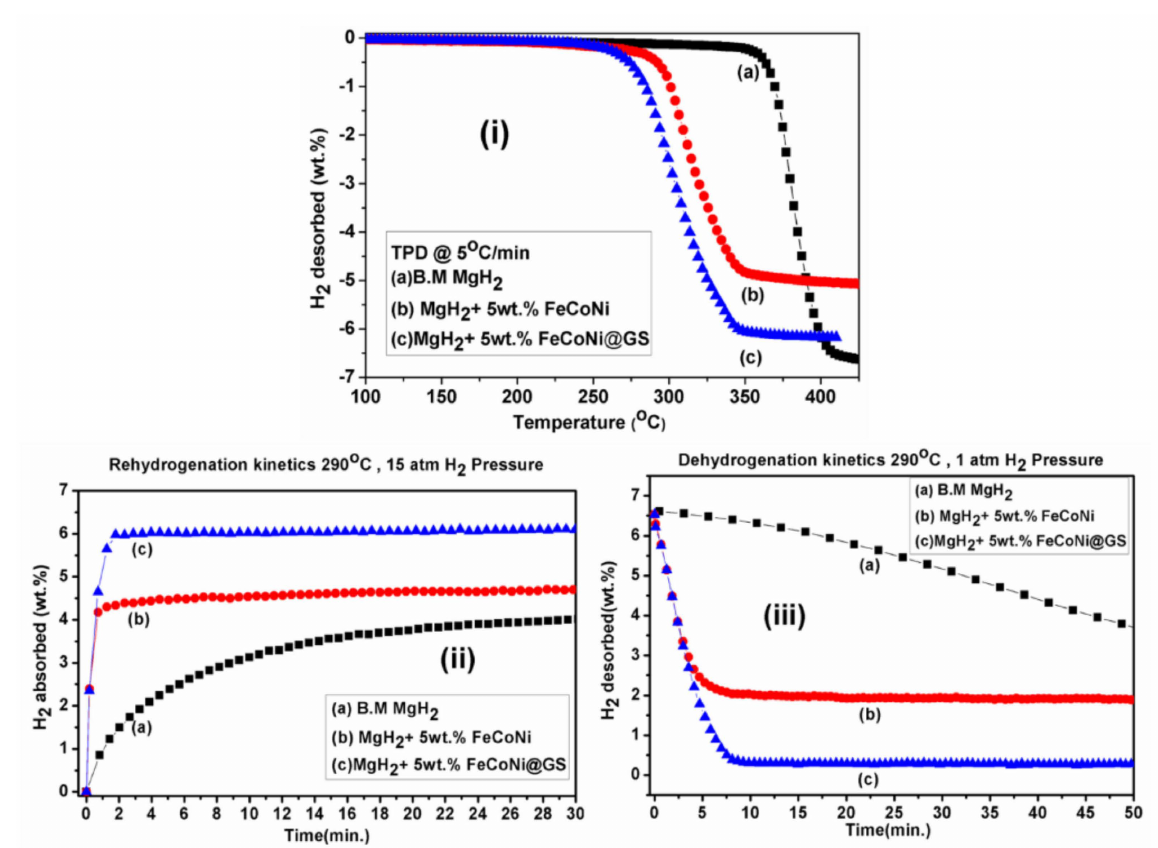
Figure 19. ( i ) TPD profile of (a) B.M MgH 2 (uncatalyzed sample); (b) MgH 2 + 5 wt% FeCoNi; (c) MgH 2 + 5 wt% FeCoNi@GS. ( ii ) Rehydrogenation kinetics curve of (a) B.M MgH 2 ; (b) MgH 2 + 5 wt% FeCoNi; (c) MgH 2 + 5 wt% FeCoNi@GS at 290 ◦ C at 15 atm. ( iii ) Dehydrogenation kinetics curve of (a) B.M MgH 2 ; (b) MgH 2 + 5 wt% FeCoNi; (c) MgH 2 + 5 wt% FeCoNi@GS at 290 ◦ C at 1 atm [138]. (Reprinted with permission from